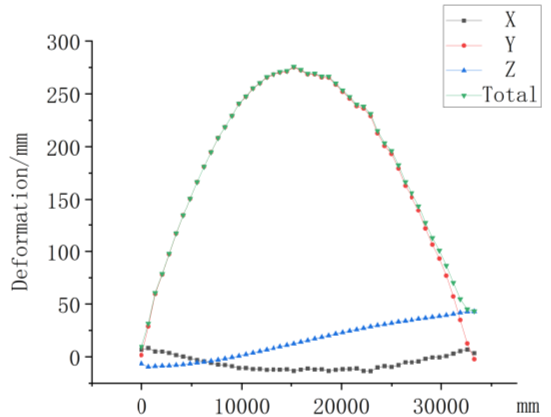
Figure 12. Deformation of the shaft column of the backless tie rod gate in the static state in different directions.